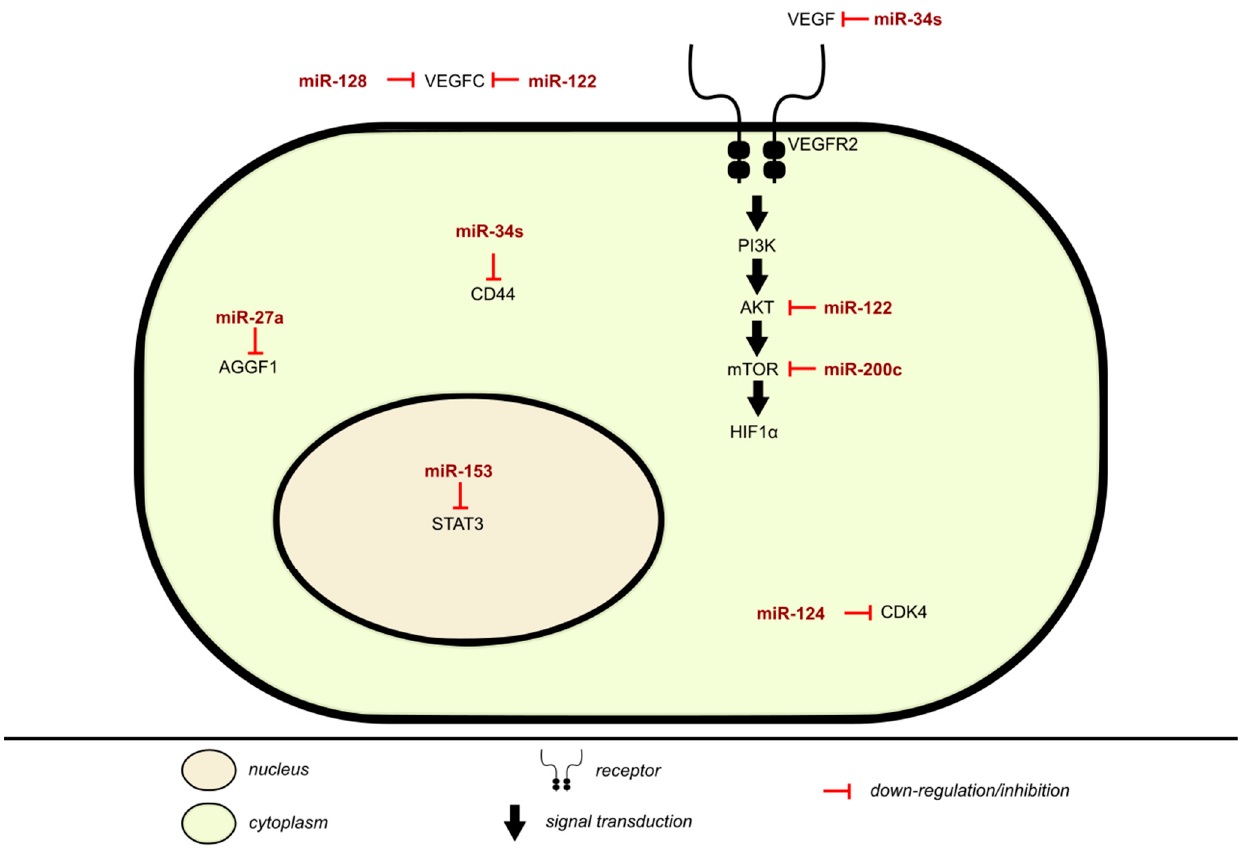
Figure 3. Inhibition of angiogenesis by miRNA in BLCA.